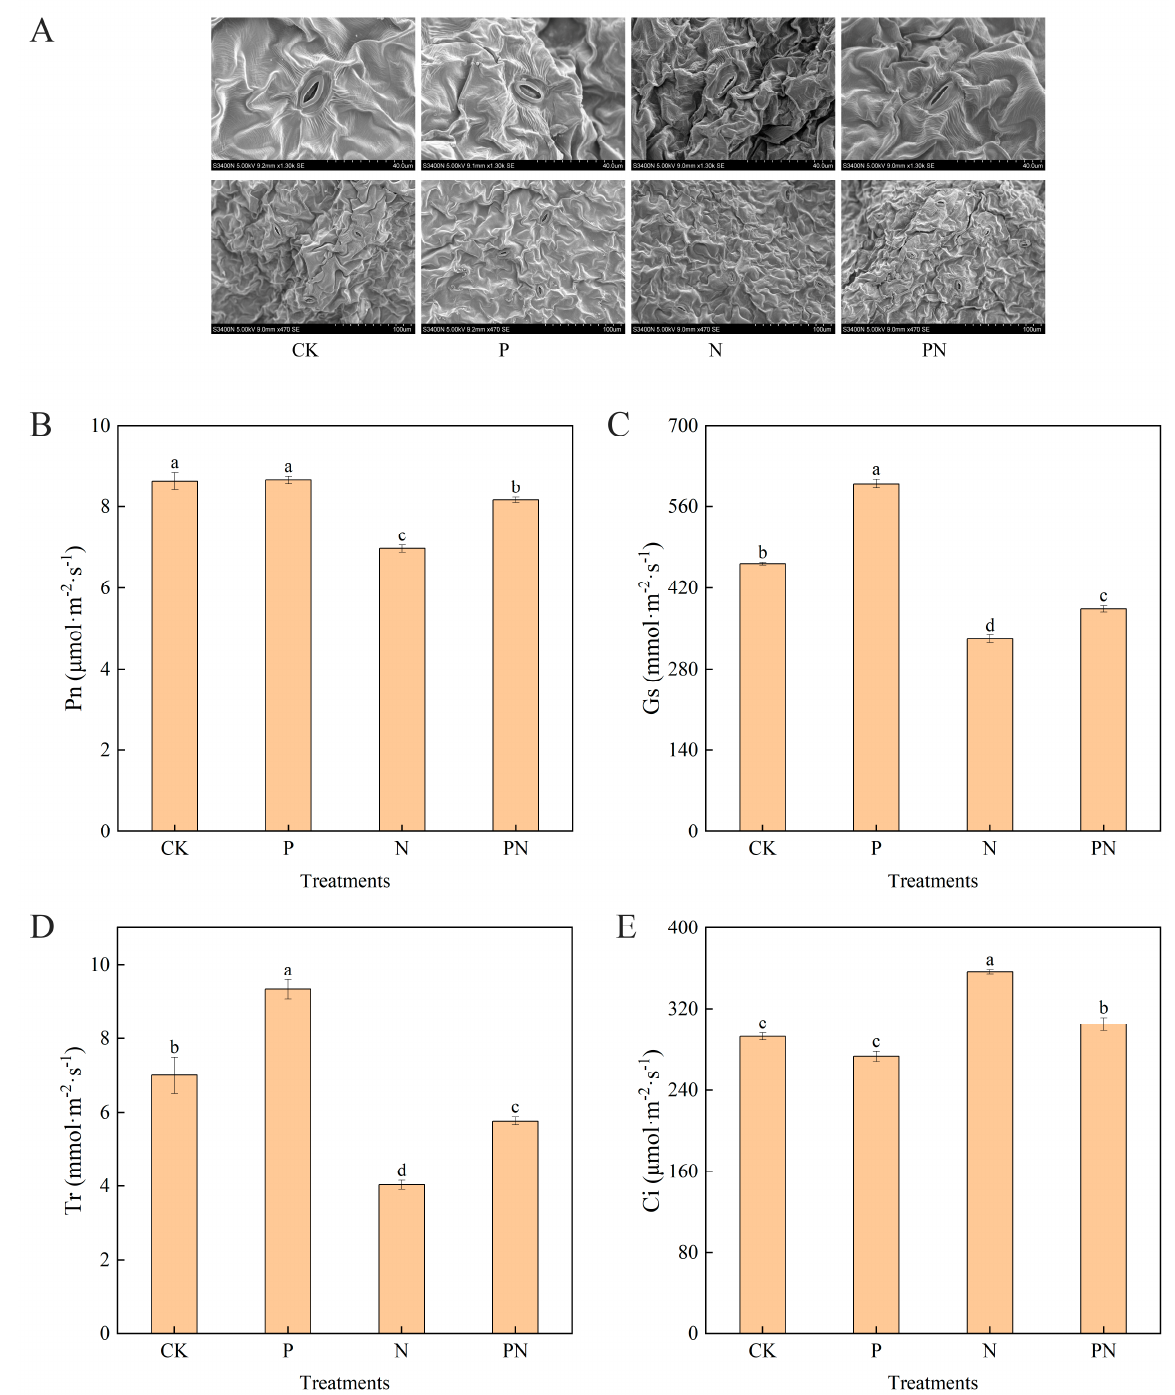
Figure 2. Effect of proline on stomatal and photosynthetic gas exchange parameters in celery under salt stress. After planting the 35-day-old seedlings for 7 days, they were treated with 0.3 mM proline solution for 7 days, after which they were watered with 100 mM NaCl solution thrice every 3 days. ( A ) Leaf stomatal morphology, 1300×, scale bars = 40 µm; 470×, scale bars = 100 µm. ( B ) Net photosynthetic rate (Pn). ( C ) Stomatal conductance (Gs). ( D ) Transpiration rate (Tr). ( E ) Intercellular CO 2 concentration (C i ). The results are expressed as the mean ± SE of three replicates, and the different letters denote the significant difference among treatments ( p < 0.05), according to Duncan’s multiple tests. CK, control. P, 0.3 mM proline. N, 100 mM NaCl. PN, 100 mM NaCl+ 0.3 mM